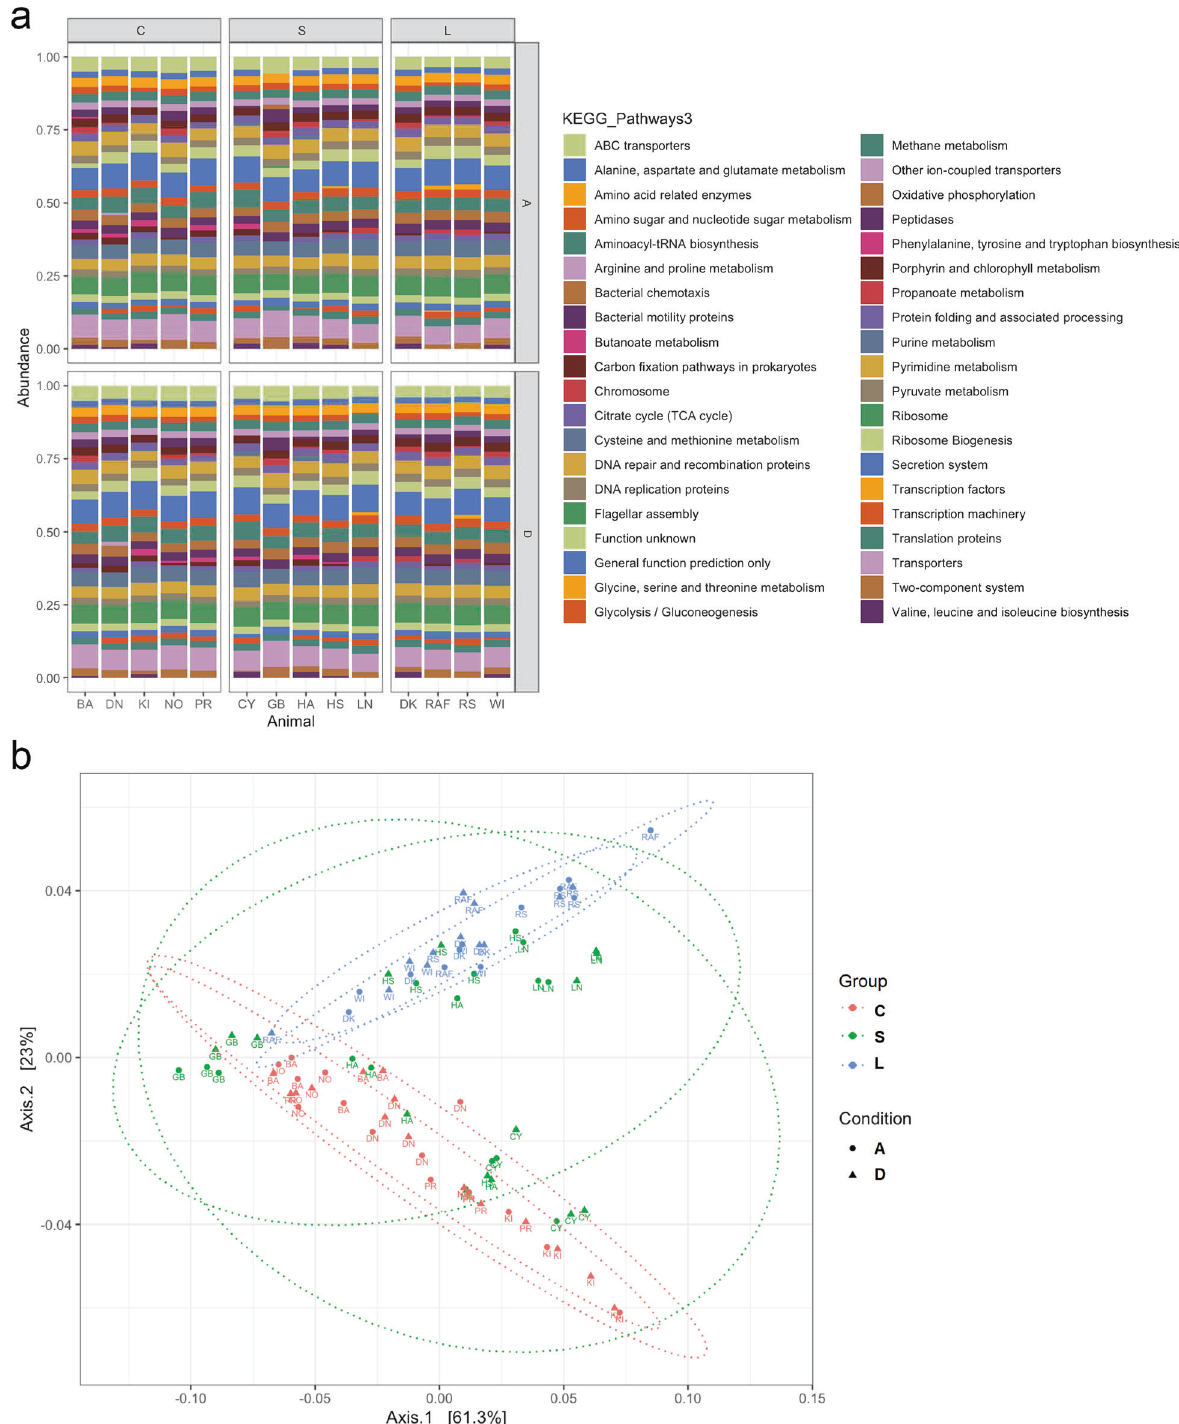
Fig. 6 Effects of chronic excessive alcohol drinking on the functional role of the gut microbiome. a Phylogenetic investigation of communities by reconstruction of unobserved states (PICRUSt) comparing functional pathways among the long-term alcohol drinking group (L), the short-term alcohol drinking group (S), and the control group (C), as well as between the drinking (D) and abstinence (A) conditions. The baboons ’ names are reported as acronyms. b Principal coordinates analysis (PCoA) plot comparing metagenome functional content of microbial taxa among group L (in blue), group S (in green), and group C (in red). Triangles represent condition D, circles represent condition A. The percent explained dissimilarity is reported in brackets on fi rst ( x axis) and second ( y axis) principal coordinate axis. The distance between the triangles and circles, respectively, represents the difference in metabolic potential of the groups of